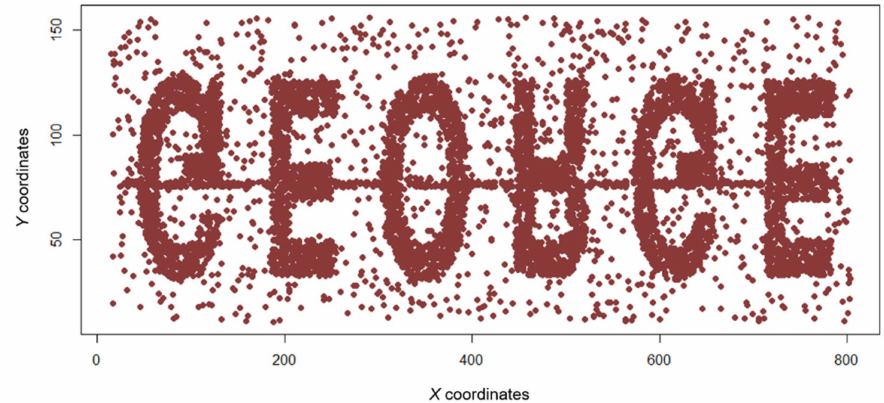
Figure 3. Spatial distribution of the t5.8k dataset.